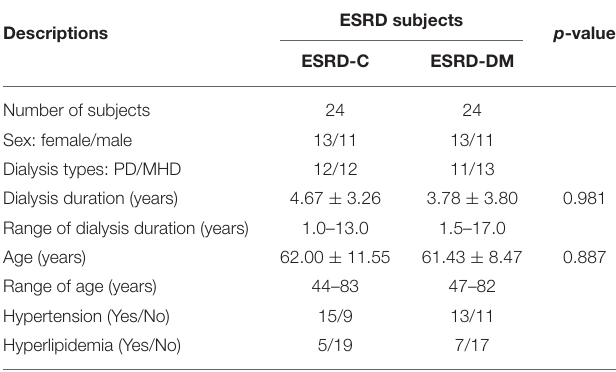
TABLE 1 | Descriptions of the clinical features of ESRD